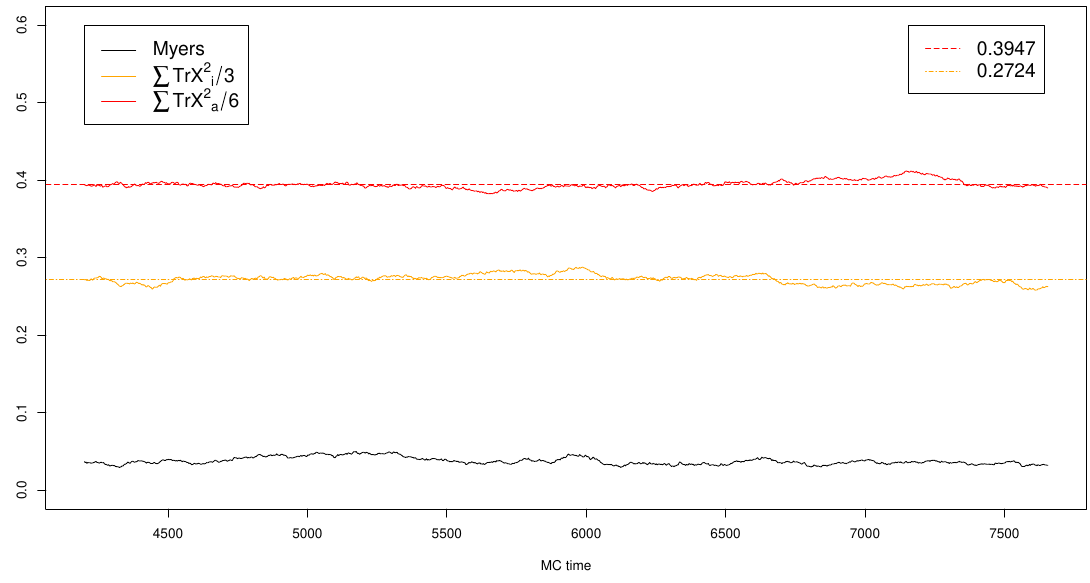
Figure 5. Fluctuations of the first three matrices Tr X 2 an obvious breaking of the symmetries. The parameters shown are N = 16 , S = 24 , T = 0 . 23 and µ = 0 . 6 . We see that the Myers term is very small, indicating not a formation of a big fuzzy sphere. On the other hand, a priori there could be many small fuzzy spheres and in such a scenario the Myers term cannot distinguish these